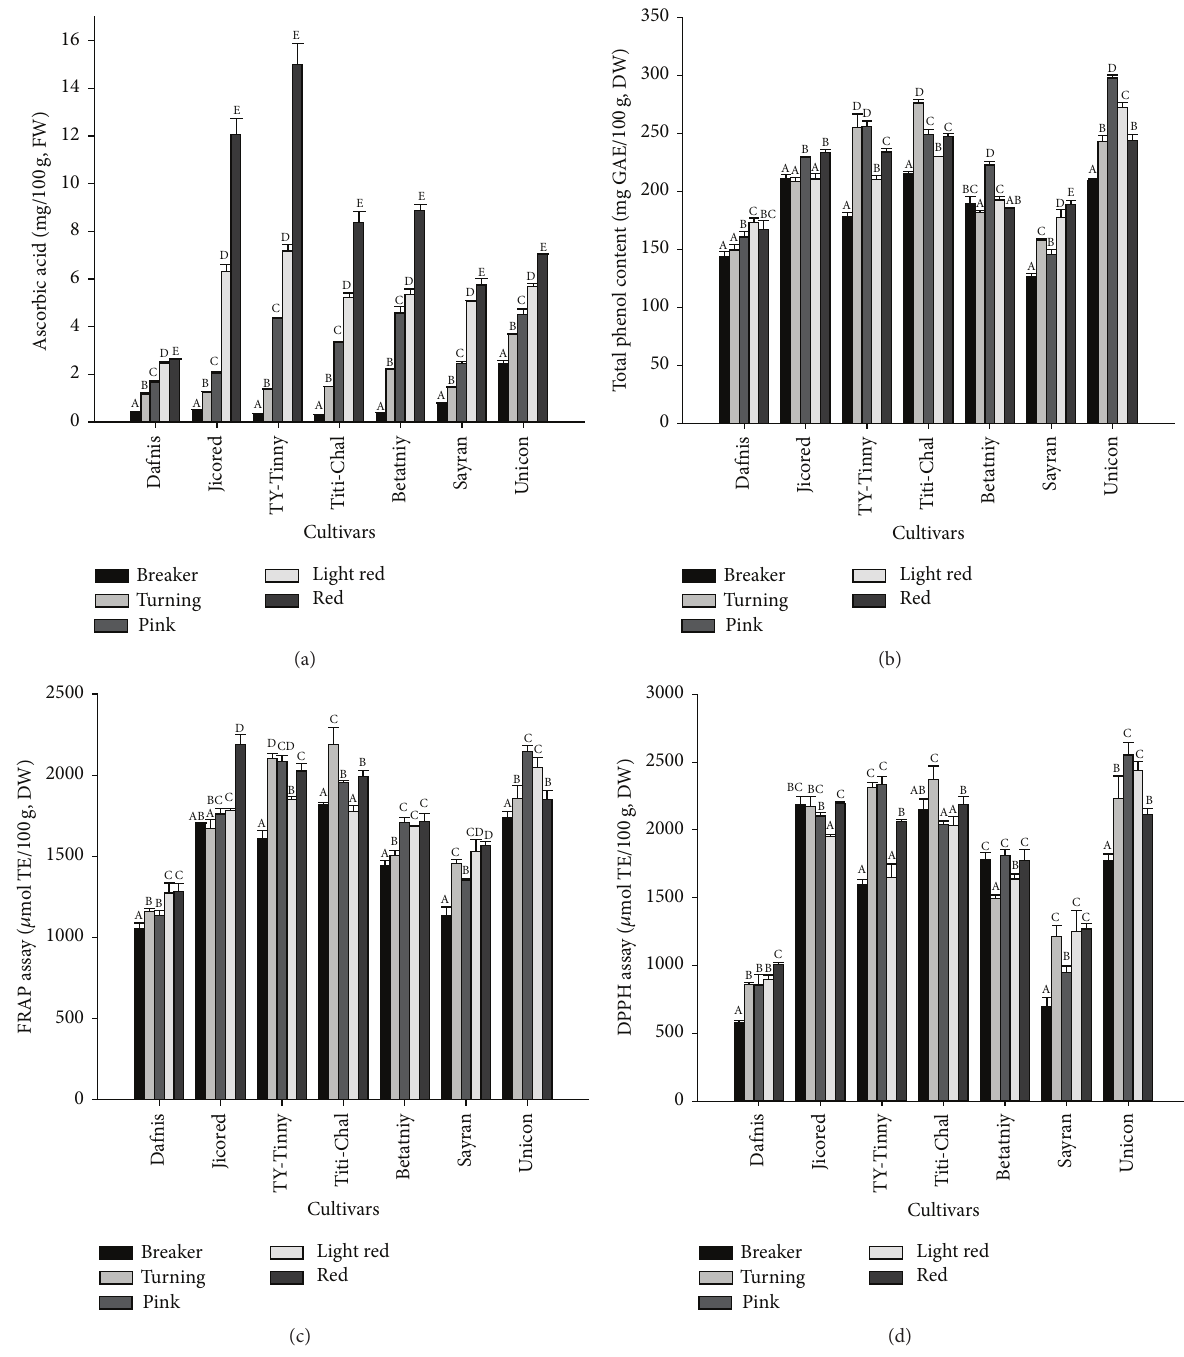
Figure 2: Changes in ascorbic acid (a), total phenol (b), and antioxidant activities (FRAP (c) and DPPH (d)) in tomato fruits as affected by ripening stages. Vertical bars represent mean ± SD of three replicates, and the different letters within the same cultivars indicate statistically significant differences at 𝑝 < 0.05 by Duncan’s multiple range test. FRAP: ferric-reducing antioxidant power, DPPH: 2,2,-diphenyl-1-